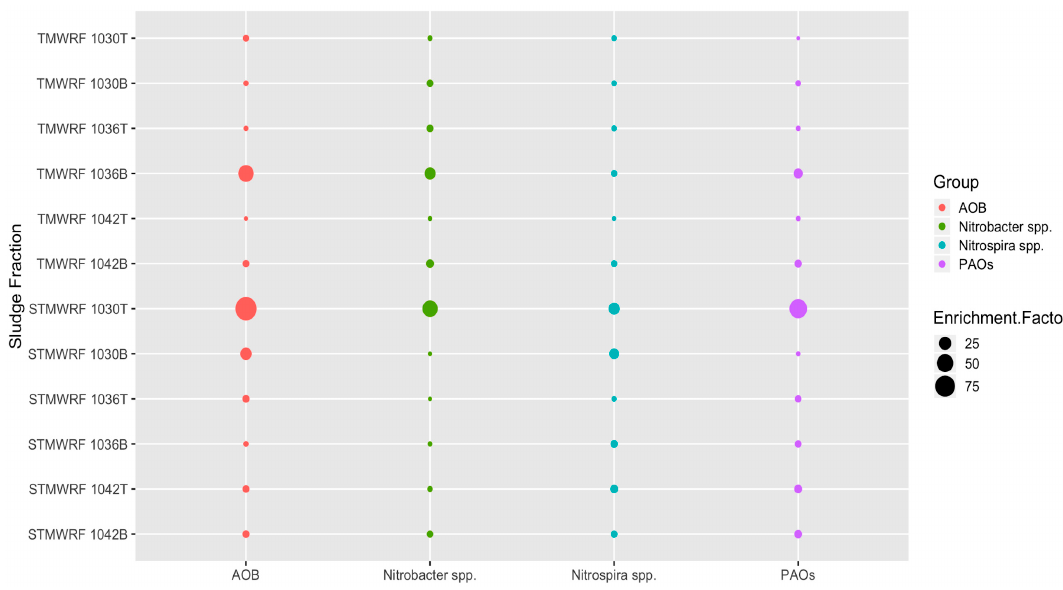
Figure 2. Enrichment factors for each microbial functional group achieved in sludge fractions separated using various homogenous densities. For example, 1030T designates the fraction lighter than 1.030 g/cm 3 and 1030B designates the fraction denser than 1.030 g/cm 3 .